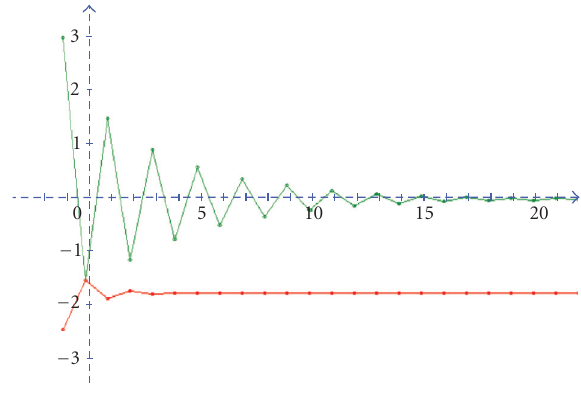
Figure 3.4. Behavior of x n and y n in the point F .